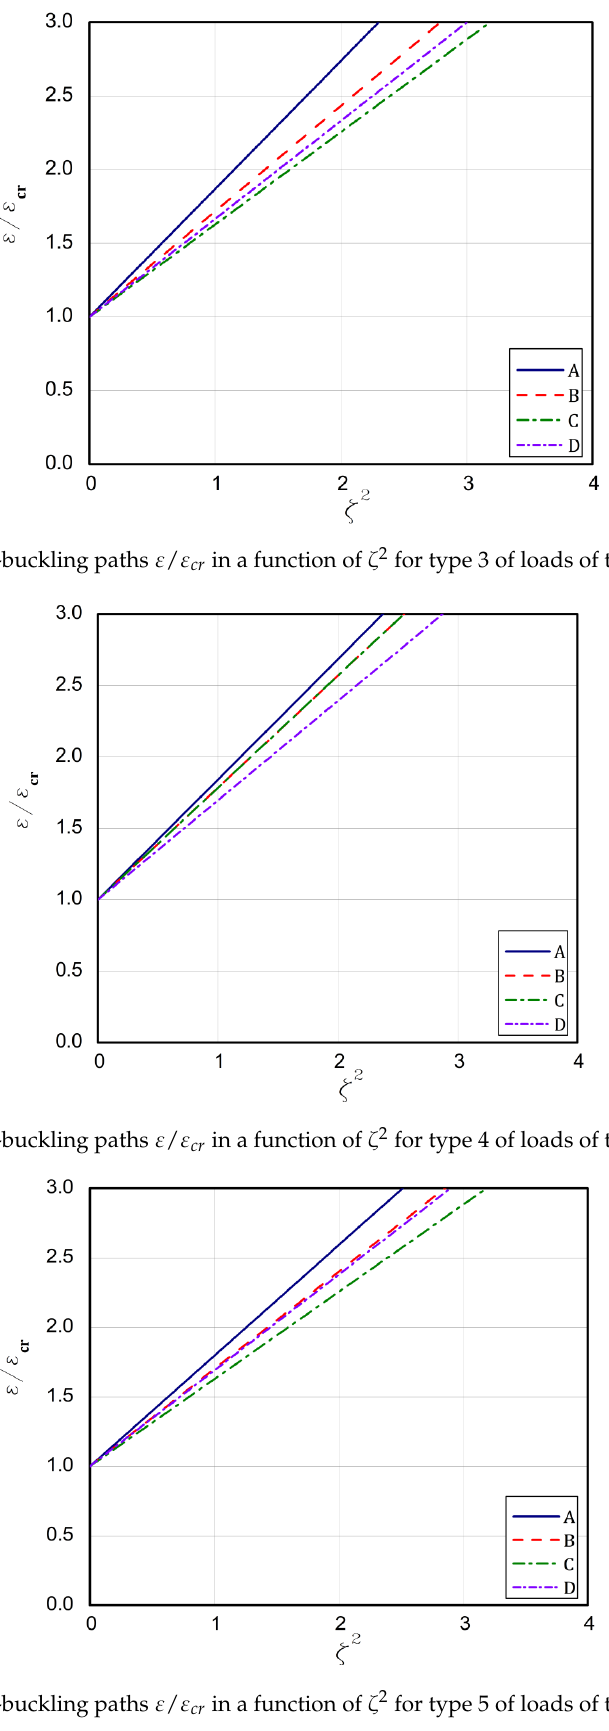
ζ 2 for type 5 of loads of the perfect cr in a function of